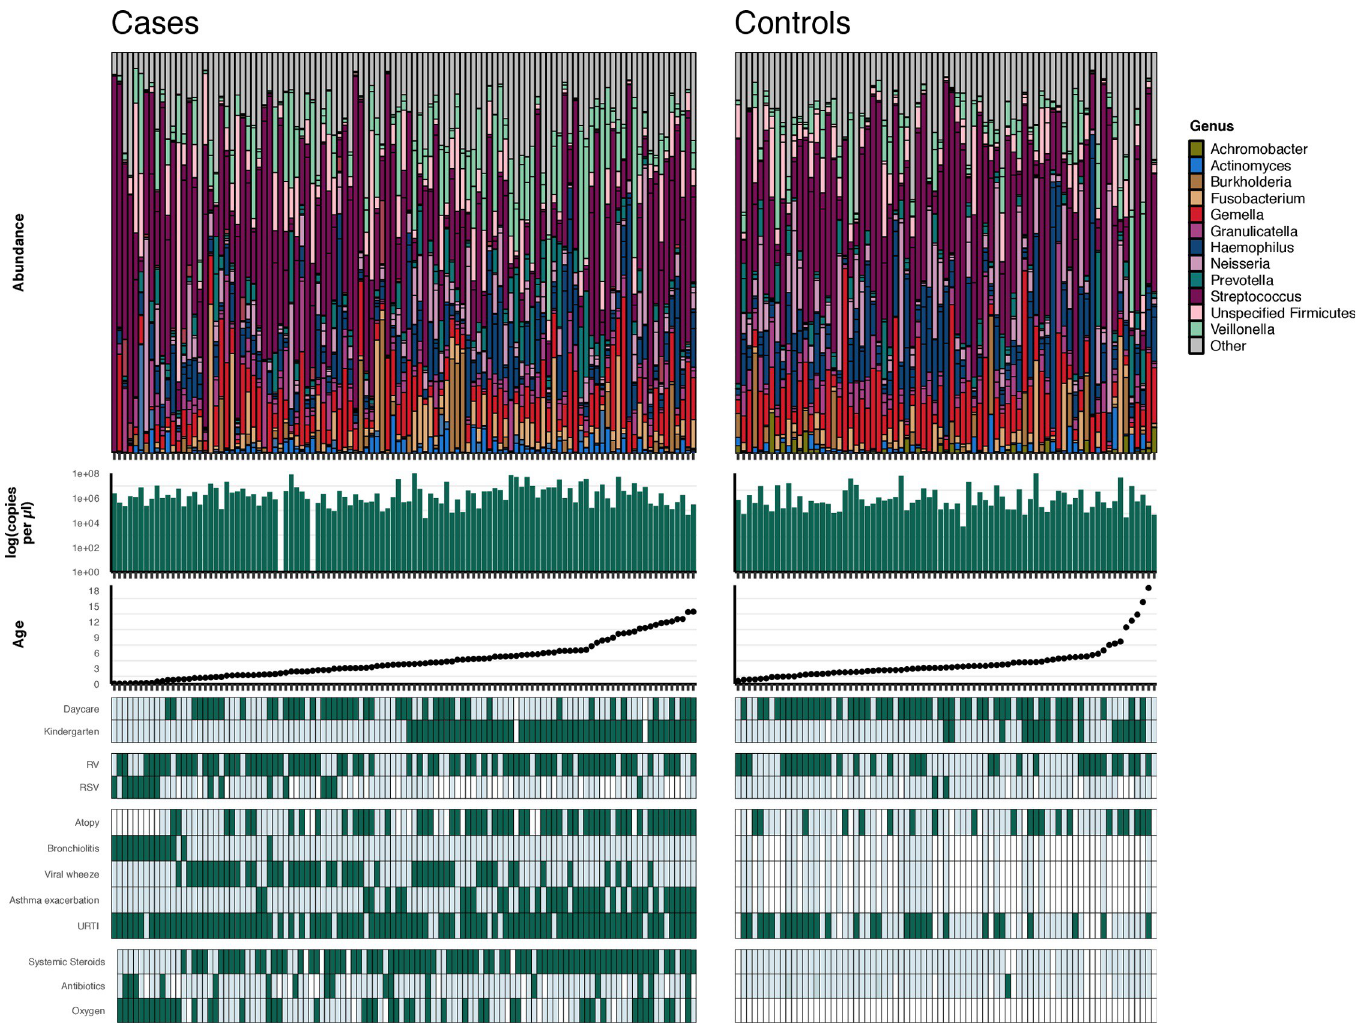
Fig 1. Stacked bar plots of cases (acute wheeze) and controls ordered by age. Bacterial biomass and patient demographics are indicated in the plots below. Dark green indicates yes while pale green indicates no, white boxes indicate NA or missing